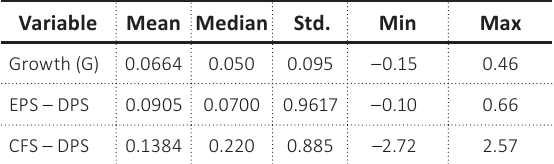
Table 1. Descriptive analysis